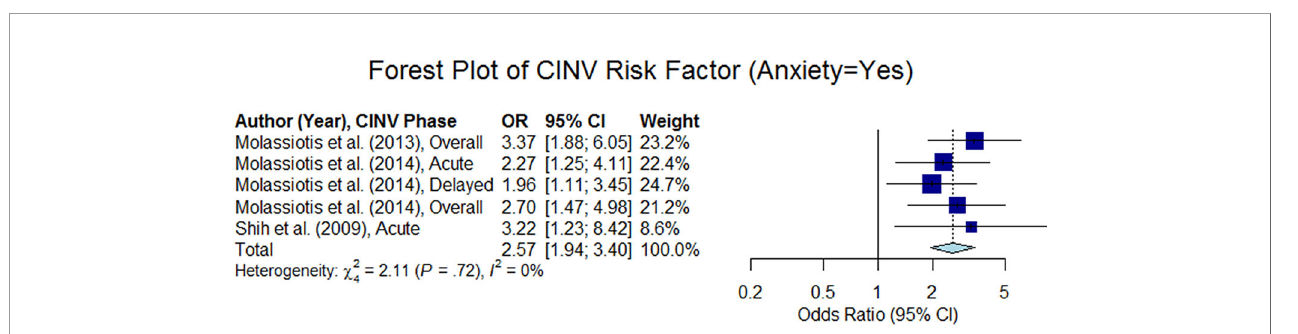
FIGURE 8 | Forest plot of Chemotherapy-Induced Nausea and Vomiting (CINV) risk factor (anxiety = yes).